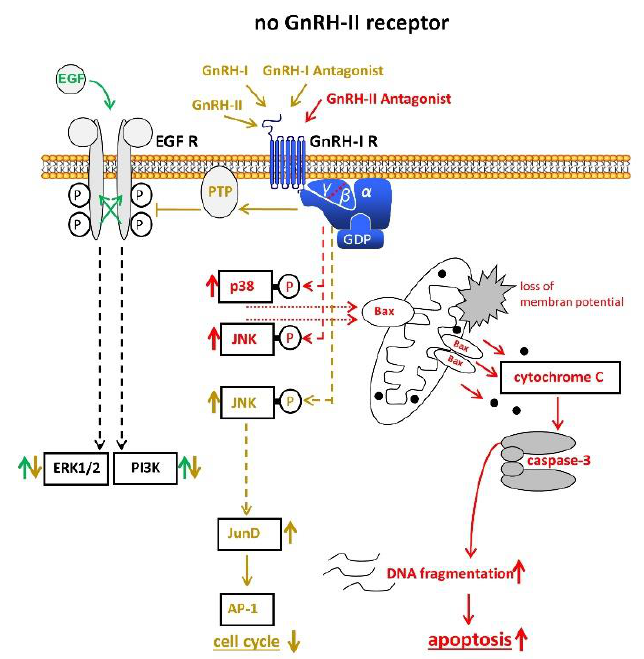
Figure 3. Signal transduction of GnRH-I and GnRH-II and their agonistic as well as antagonistic analogs through the GnRH-I-R if no functional GnRH-II-R is expressed. For details, cf. Figures 1 and 2. AP-1, activvator protein-1. Bax, B-cell lymphoma 2 (Bcl-2)-associated X protein. EGF, epidermal growth factor. EGF-R, EGF receptor. ERK1/2, p44/42 mitogen-activated protein (MAP) kinase. GDP, guanosindiphosphat. GnRH, gonadotropin releasing hormone. JNK, c-Jun N-terminale kinase. JunD, transcription factor JunD. P38, mitogen-activated protein kinase P38. PI3K, phosphoinositide 3-kinase. PTP, protein tyrosine phosphatase.